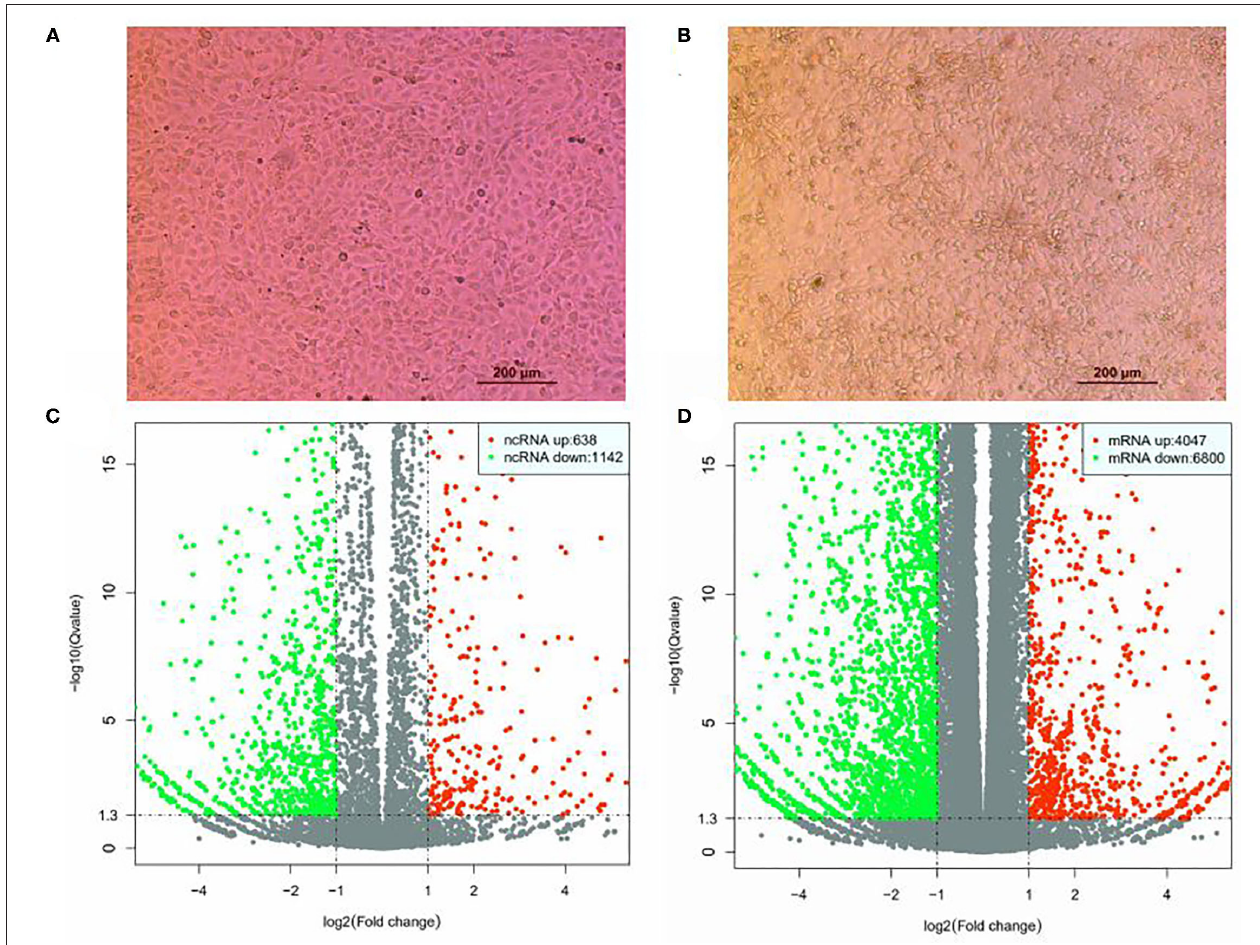
FIGURE 1 | Differential expression of lncRNAs and mRNAs in SVV-infected and mock control PK15. (A) PK15 cells uninfected with SVV. (B) PK15 cells infected with SVV. (C) Volcano plots of DE lncRNAs. (D) Volcano plots of DE